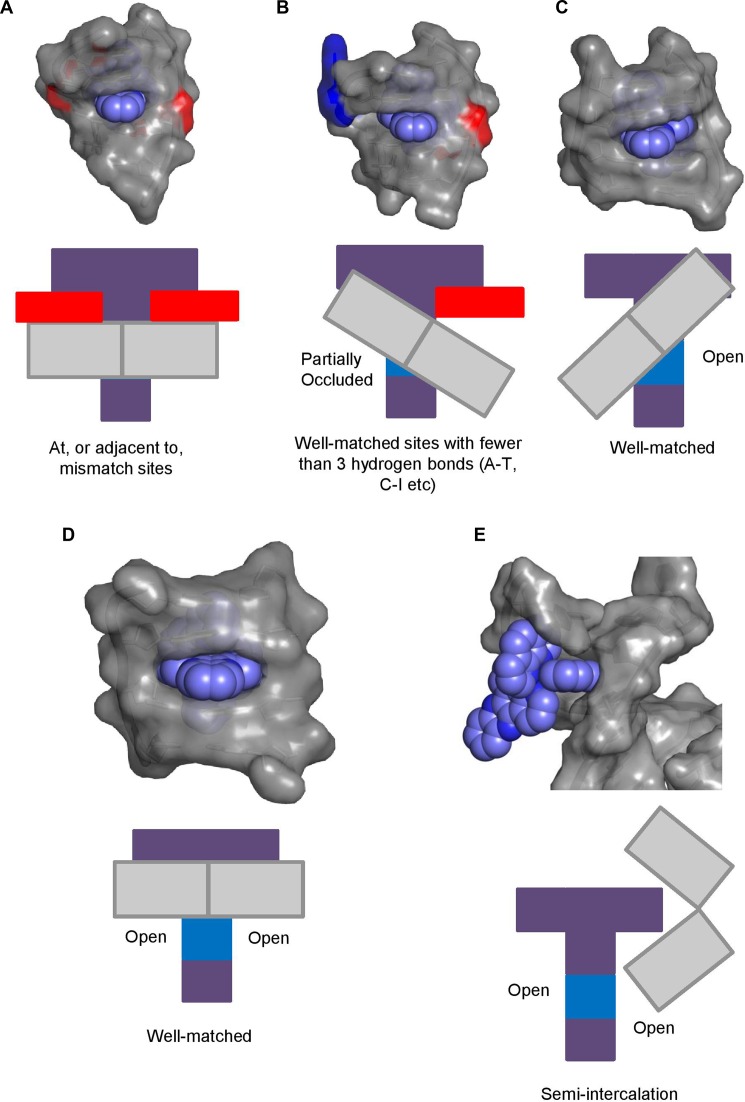
Five possible binding modes for Δ-[Ru(phen)2(dppz)]2+ to DNA. (A) The complex binds at, or adjacent to, a mismatch site. The flanking adenine (or purine) bases stack on the ancillary ligands, reducing intercalation depth and preventing the dppz nitrogen atoms from hydrogen bonding to solvent water molecules (14). (B) Insertion into well-matched sites with less than three H-bonds between the bases. The purine flips out and is able to π-stack onto an ancillary ligand. The pyrimidine also flips out but does not stack. This partially, but not completely, occludes one dppz nitrogen (26). (C) Canted (angled) intercalation into a well-matched base pair leaves one dppz nitrogen atom entirely exposed to solvent (8). (D) Model for intercalation by a Δ enantiomer at a 5′-AT/AT-3′ step. The model was generated by changing both the enantiomer and the base sequence (TA → AT) of the DNA step starting from PDB code 3U38(7). Symmetrical intercalation into this step should expose both dppz nitrogen atoms to the solvent. (E) Semi-intercalation by an ancillary ligand into the DNA duplex, exposing both phenazine nitrogen atoms to solvent. DNA is drawn in grey as a solvent-accessible surface with a radius of 1.5 Å. The carbon atoms of the complex are in purple with nitrogen atoms in blue. In the schematic diagram, the complex is drawn in purple with dppz nitrogen atoms as blue. DNA bases are represented by grey blocks with flanking adenine bases as red rectangles.